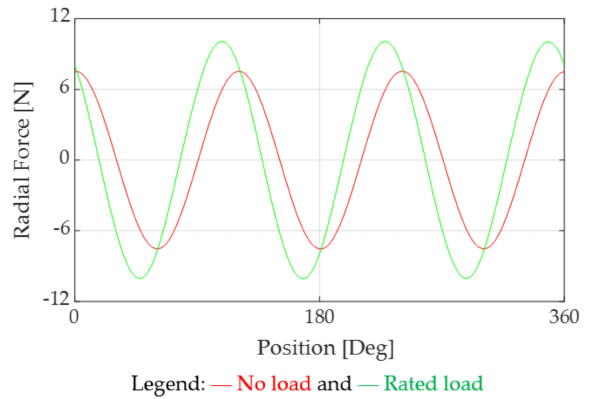
Figure 3. Comparison of unbalanced radial force for the 3Slot-1CS motor